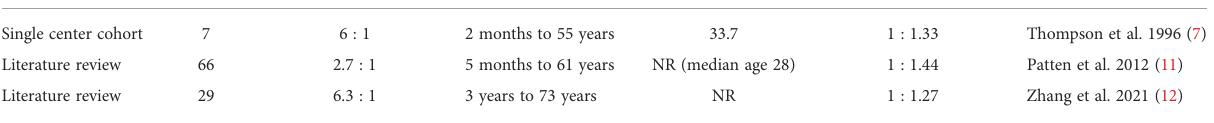
TABLE 4 Demographic characteristics of patients reported in